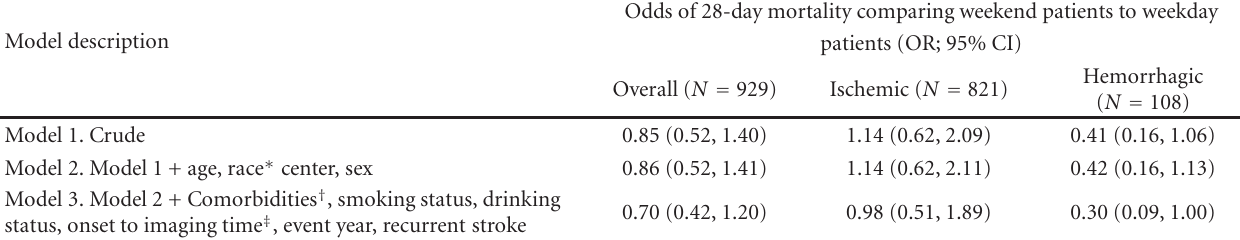
Table 3: Sensitivity analysis results. Weekend e ff ect ∗ among stroke patients overall and by stroke type in the atherosclerosis risk in communities (ARIC) study (1987–1989).